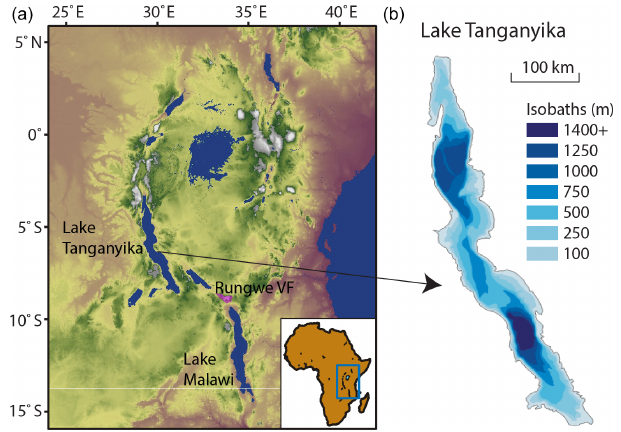
Figure 1. Topographic map of East Africa from SRTM data show- ing the location of Lake Tanganyika; figure modified from Russell et al. (2012). The lower left inset shows the location of the region within Africa. In panel (b) , a bathymetric map of Tanganyika illus- trates the major depositional sub-basins within the